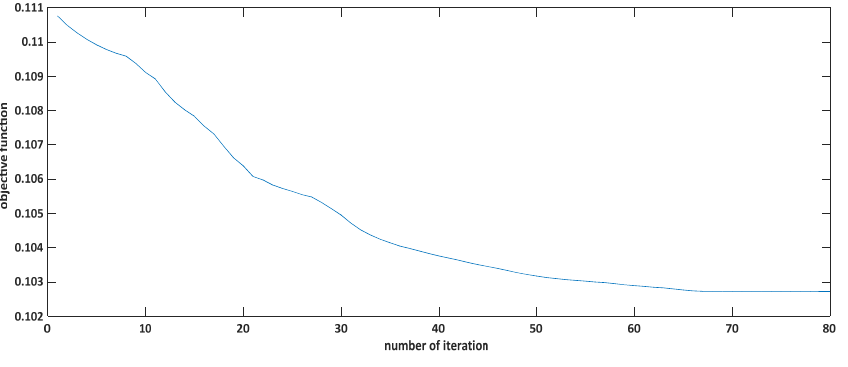
Figure 7. Convergence curve of the scenario 2.